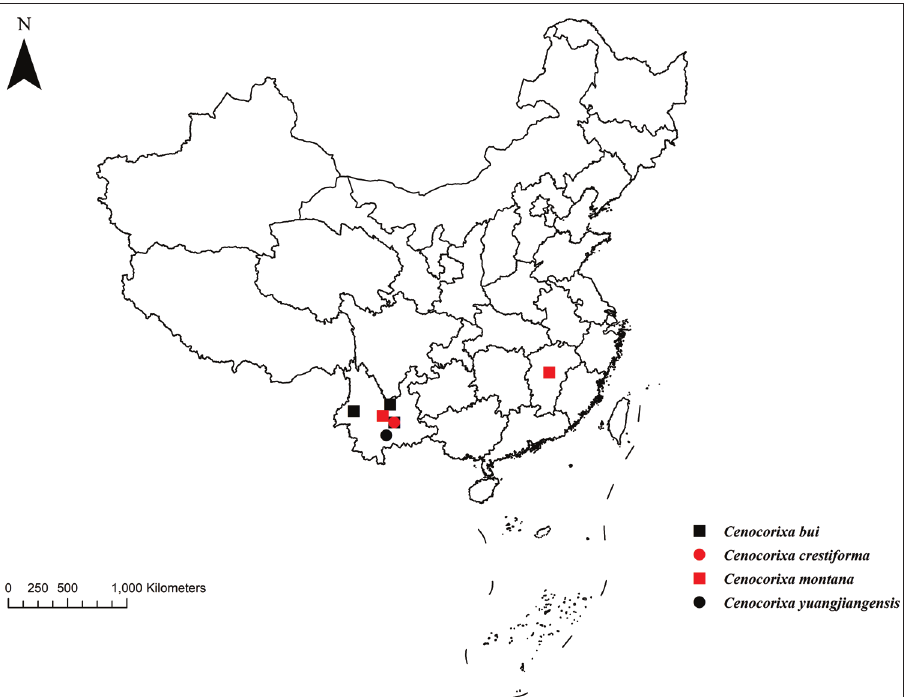
Figure 4. Distribution of Cenocorixa within